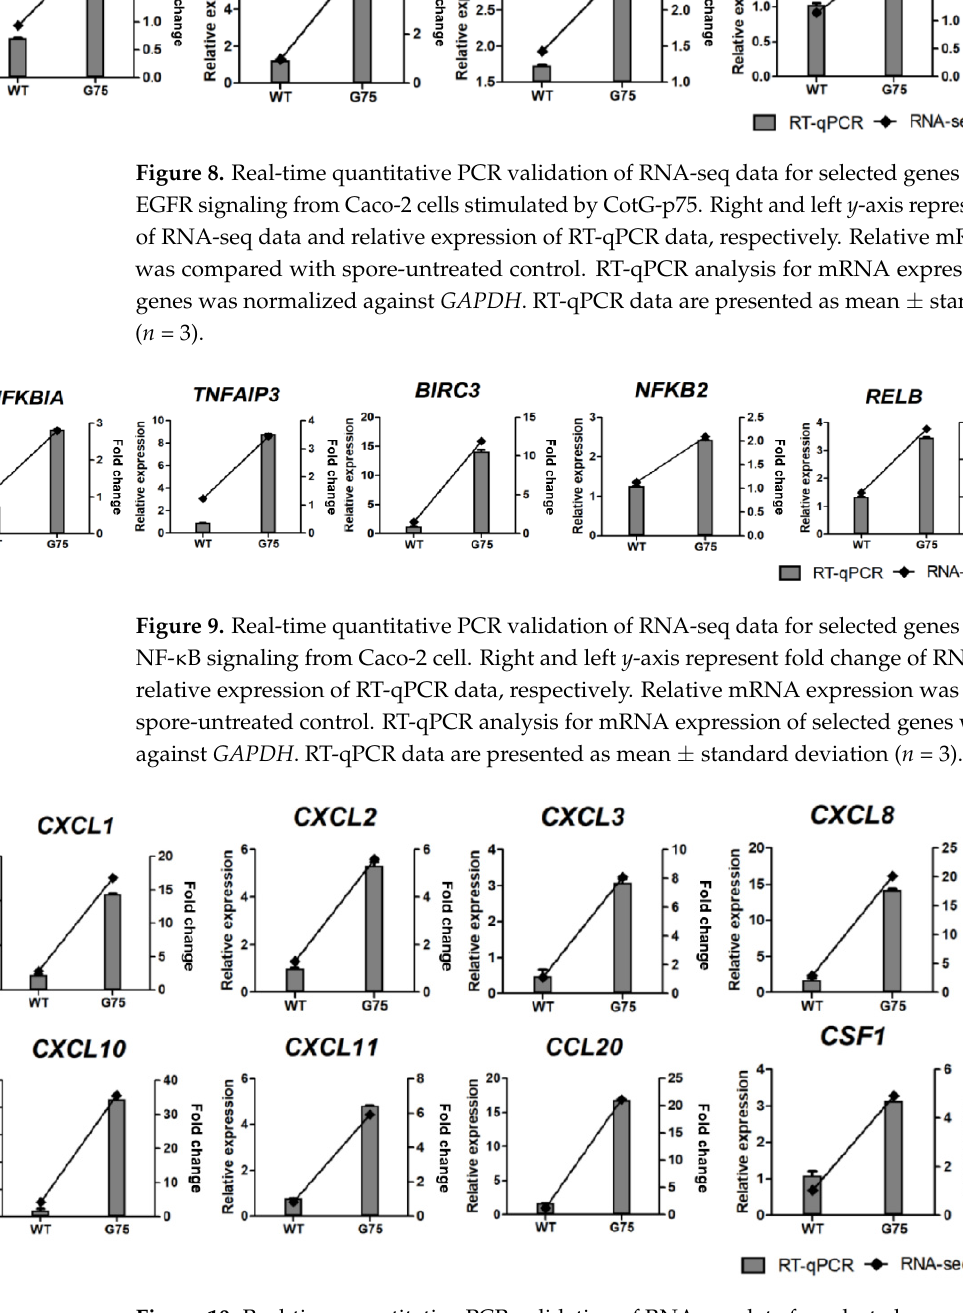
Figure 10. Real-time quantitative PCR validation of RNA-seq data for selected genes associated with immune response from Caco-2 cells stimulated by CotG-p75. Right and left y -axis represent fold change of RNA-seq data and relative expression of RT-qPCR data, respectively. Relative mRNA expression was compared with spore-untreated control. RT-qPCR analysis for mRNA expression of selected genes was normalized against GAPDH . RT-qPCR data are presented as mean ± standard deviation ( n =